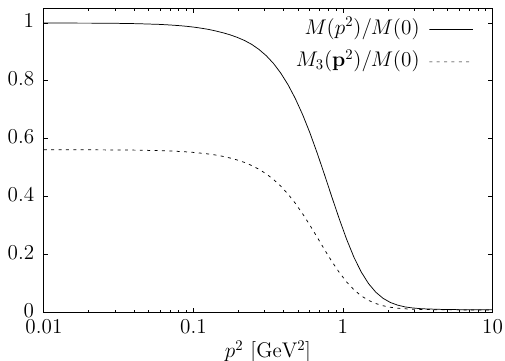
Figure 4. Mass function obtained from the (quenched) solution of the quark gap equation. Results are presented for g 2.1 (full curve) and g = 0 (dashed curve). (cid:39)